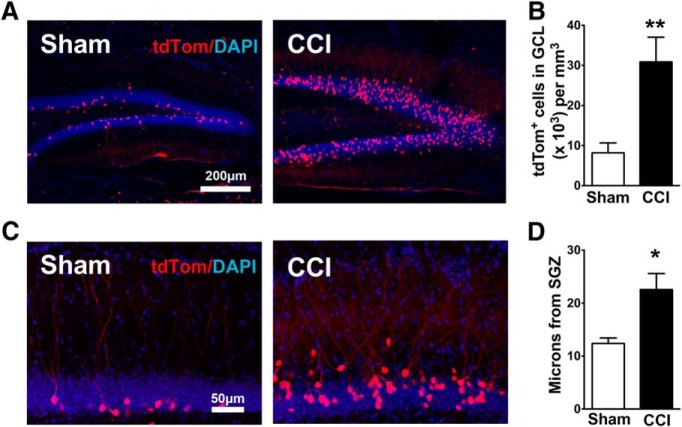
Neurons born shortly after CCI survive and maintain their aberrant localization in maturity. A, Representative images of ∼4-week-old tdTom+ cells from the ipsilateral hippocampus of DcxCre/tdTom sham and CCI-treated mice, in which cells born after CCI were permanently pulse labeled with tdTomato. B, One month after injury, CCI-treated mice had more tdTom+ cells in the ipsilateral granule cell layer of the dentate gyrus compared with sham mice (**p = 0.008729, n = 6 mice/group). C, Representative images of tdTom+ cell dispersion in the granule cell layer of the ipsilateral dentate gyrus. D, CCI-treated mice had greater cell migration in the ipsilateral dentate gyrus compared with sham mice (*p = 0.04230, n = 6 mice/group).